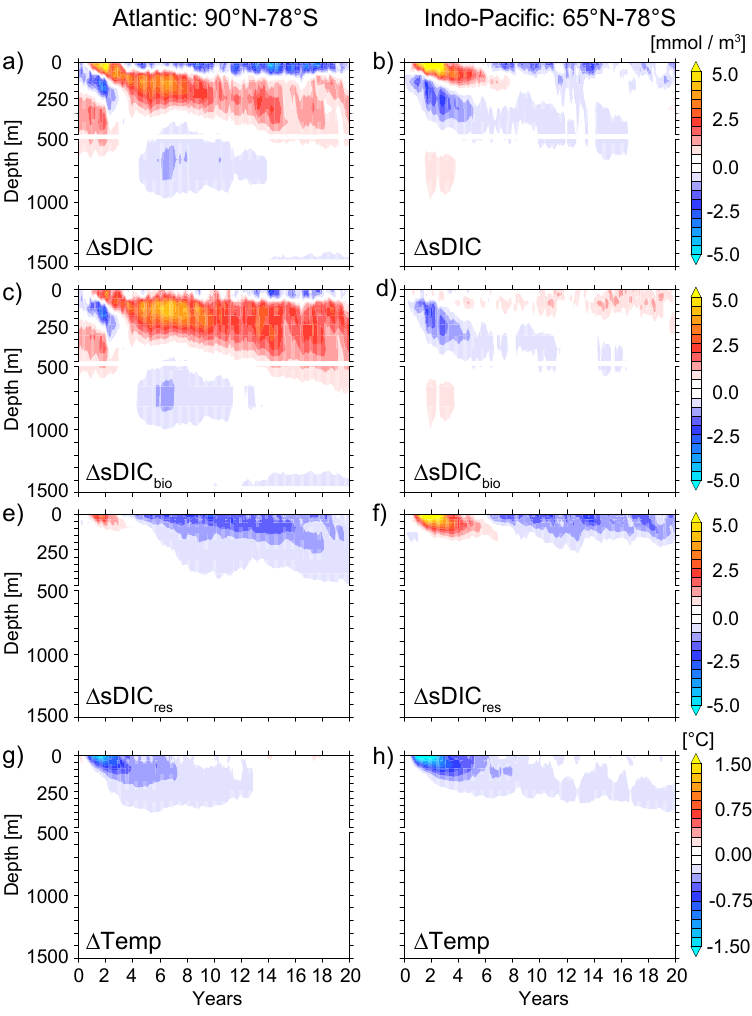
Fig. 11. Hovm¨oller diagram of monthly mean s DIC, s DIC bio , s DIC res and potential temperature differences between the Pin.10x case and the control simulation in the Atlantic (including the Arctic Ocean; a, c, e, g ) and the Indo-Pacific Ocean (b, d, f, h) at different depths. The volcanic eruption starts in year